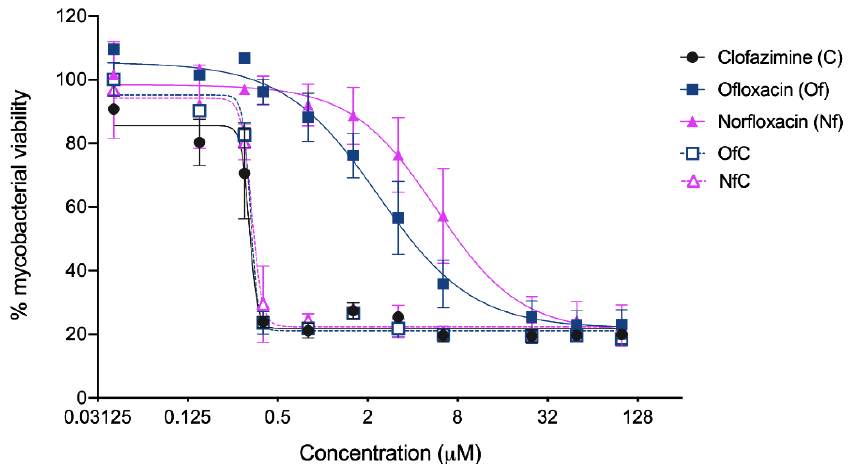
Figure 3. Antimycobacterial activity of the API-OSs and their parent drugs. The symbols represent the averages ± standard deviations of two to three independent experiments, presented as percentages of viable mycobacteria relative to the non-treated mycobacteria. The lines represent the non-linear 4PL regression obtained in the GraphPad software for each experimental condition.